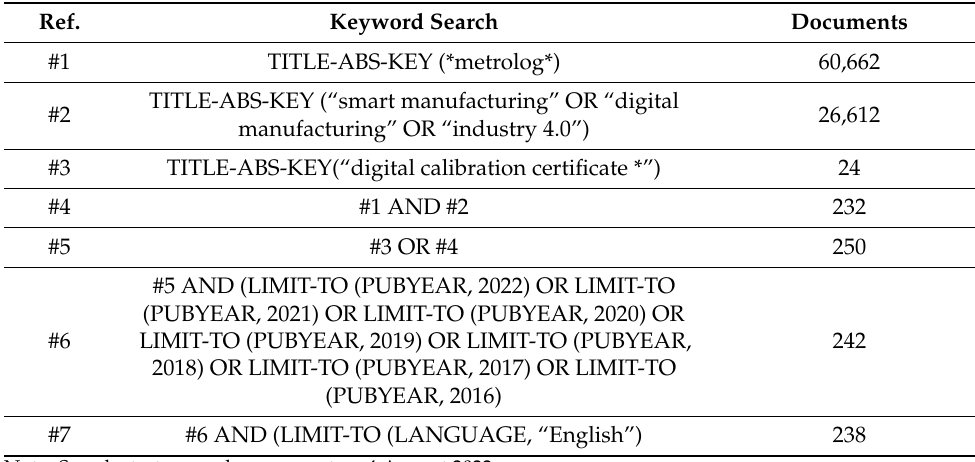
Table A2. Search strategy in the Scopus database.